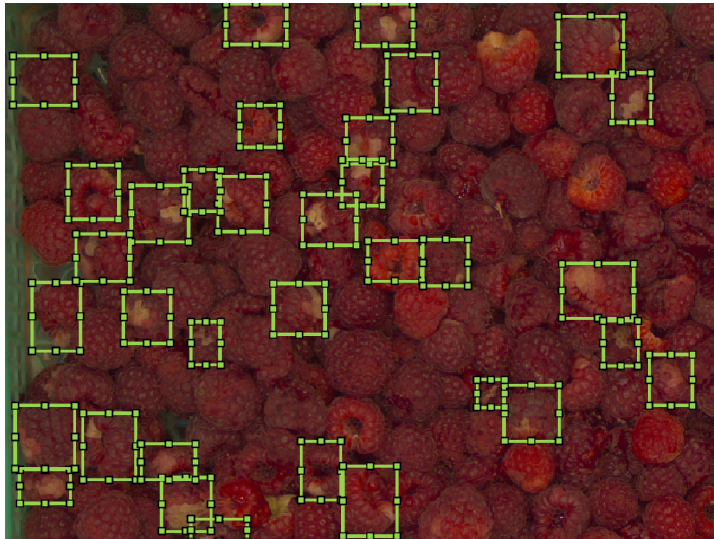
Figure 4. Raspberry images labeled example. Due to the problem to resolve being to detect red raspberry quality, the goal is to precisely locate each raspberry in a tray image using a bounding box and label it with the relevant class, disease, or defect. Note that these bounding boxes vary greatly in size and can be located in any region of a tray image. Therefore, the first task is to generate a large set of ground truth bounding boxes to design a correct classifier to detect raspberry